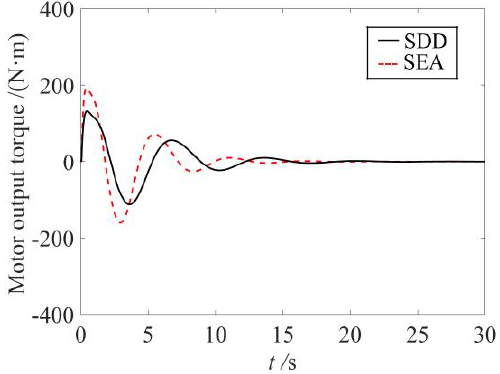
Figure 5. 1st joint motor output torque.